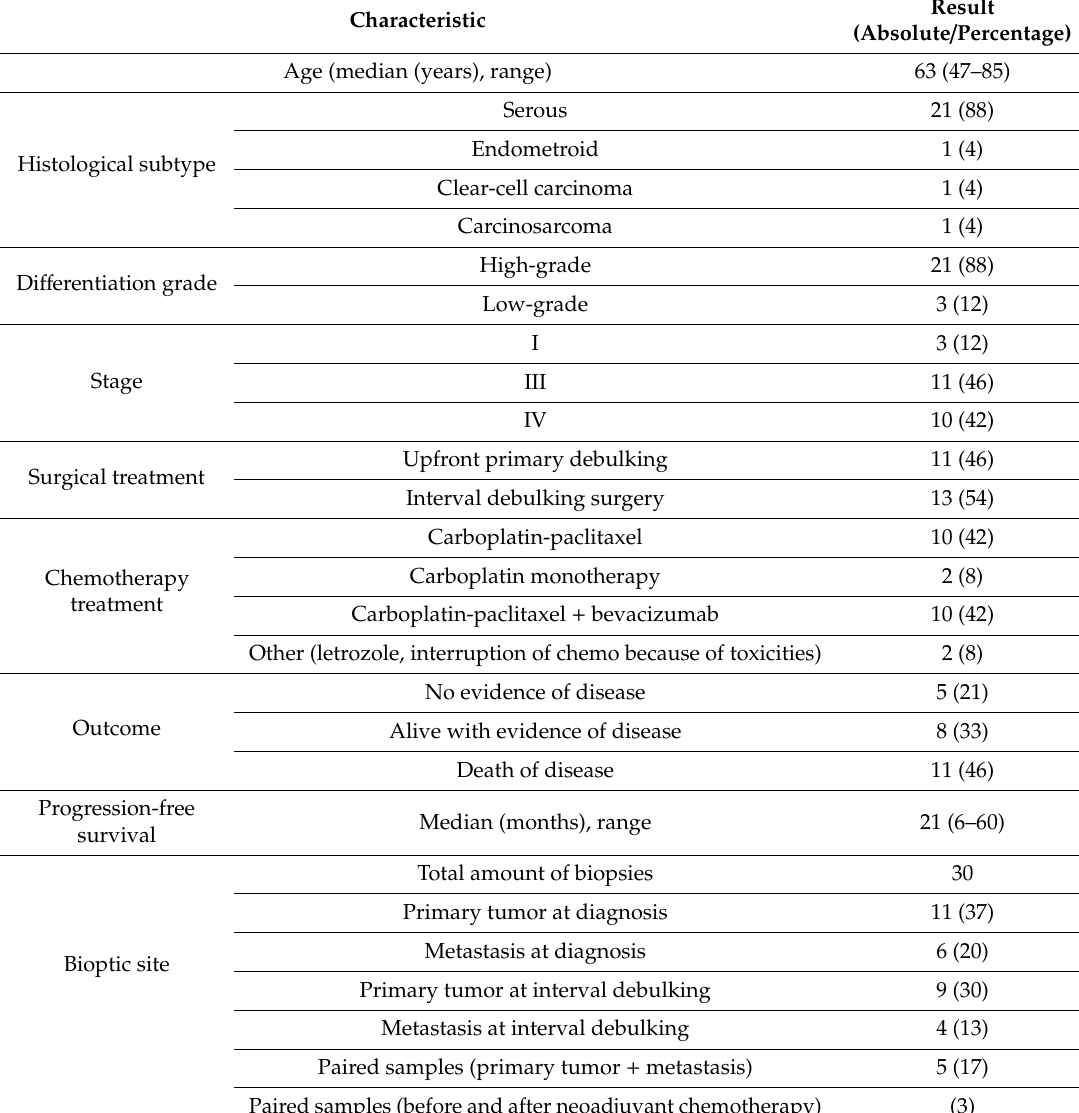
Table 1. Patient characteristics ( n =